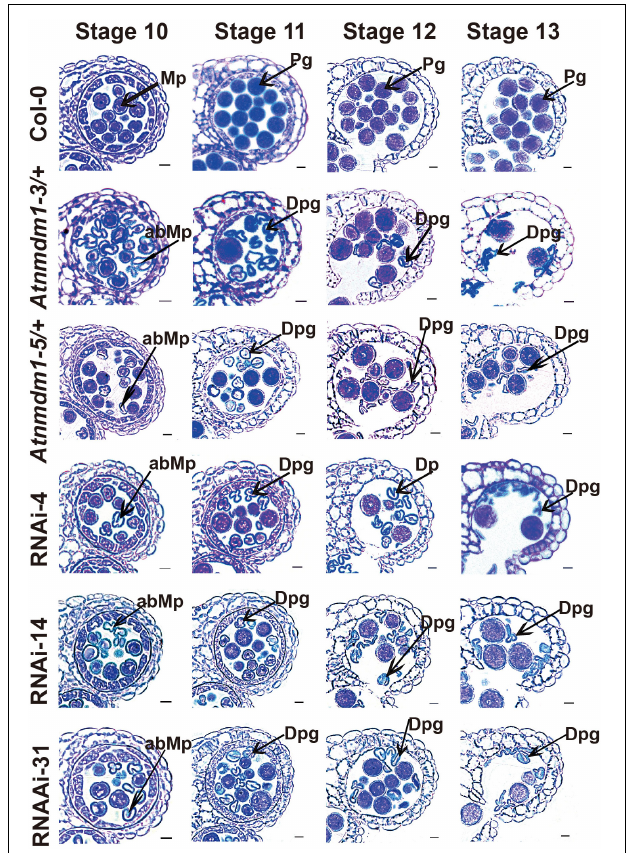
FIGURE 4 | The AtNMDM1 + / − mutants and RNAi lines were defective in pollen development. Semi-thin cross-sections of anthers from wild type, two AtNMDM1 + / − mutants: Atnmdm1-3/ +, Atnmdm1-5/ +, and three AtNMDM1 RNAi lines, RNAi-4, RNAi-14, and RNAi-31 were stained with toluidine blue. Anthers from stages 10–13 are shown. Microspores or pollen with reduced or completely lacking cytoplasm were defined as degenerate. Note that degenerate microspores were evident in two AtNMDM1 + / − mutants: Atnmdm1-3/ +, Atnmdm1-5/ + and three AtNMDM1 RNAi lines RNAi-4, RNAi-14, and RNAi-31 from stages 10 to 13. Mp, microspore; abMp, abnormal microspore; Pg, pollen grain; Dpg, degenerated pollen grain. Bar = 10 µ